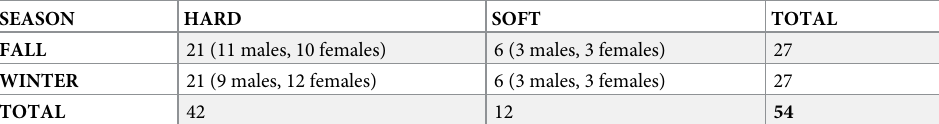
Table 1. Total number of red squirrels, Tamiasciurus fremonti fremonti translocated in the White Mountains (Arizona, USA) from 2018 to 2020, by sex, season (fall and winter), and translocation type (soft and hard).